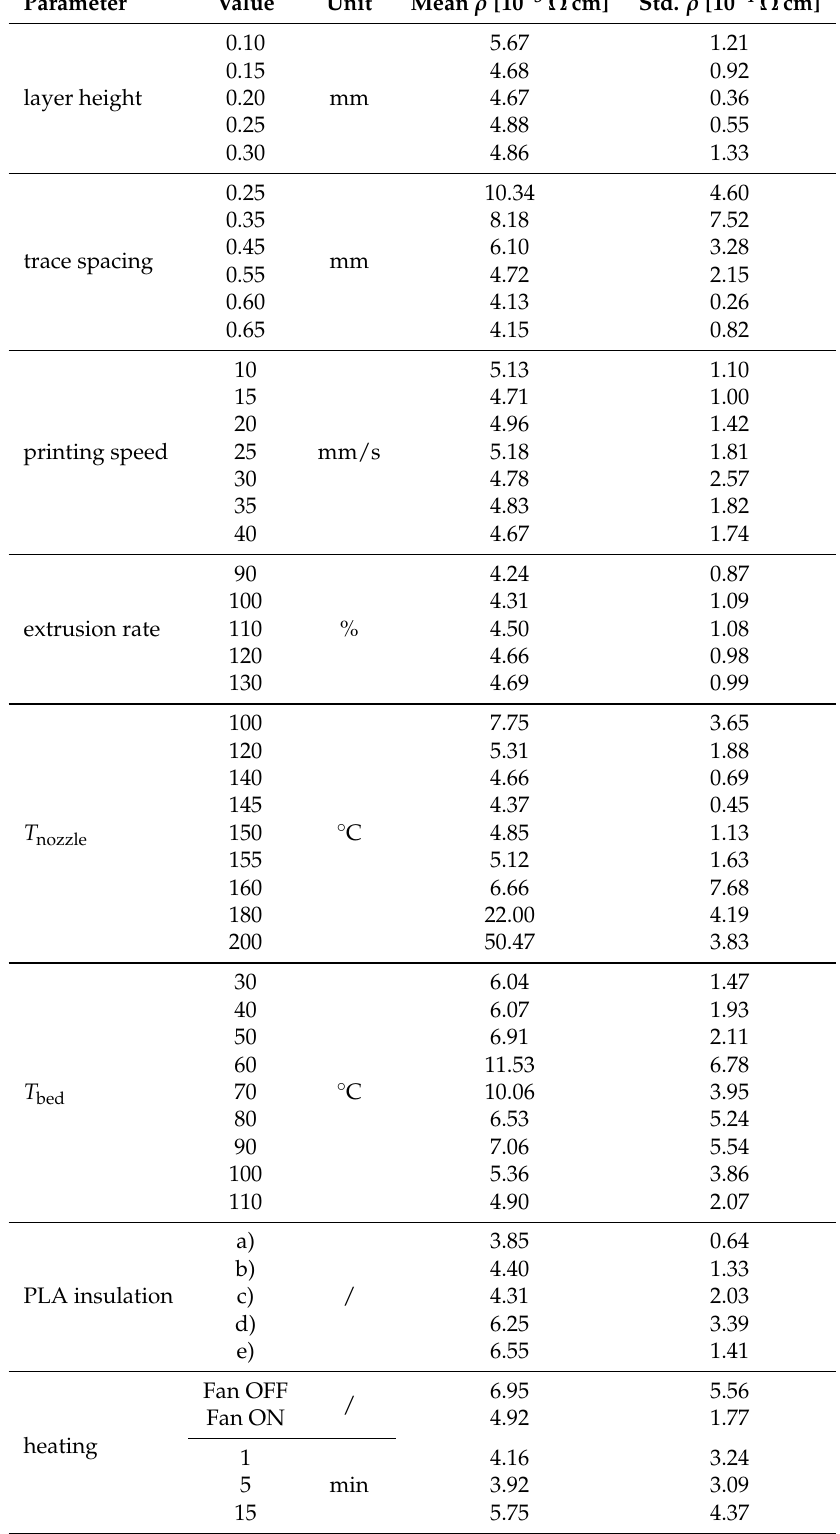
Table 3. Resistivity measurement results: average resistivity and standard deviation (std.) for every parameter value consisting of five identical conductive samples printed on shared PLA sample